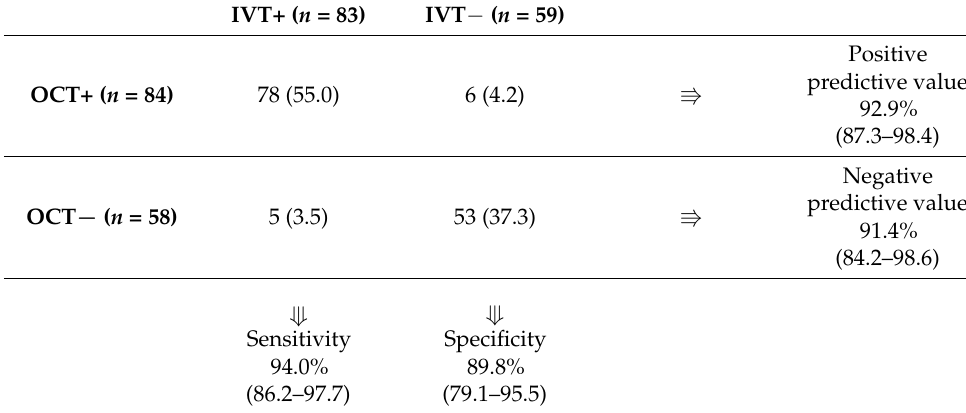
Table 2. Contingency table comparing optical coherence tomography (OCT)-guided strategy with the gold standard (OCT + visual acuity test), in the decision for retreatment with intravitreal injection (IVT) of anti-VEGF.